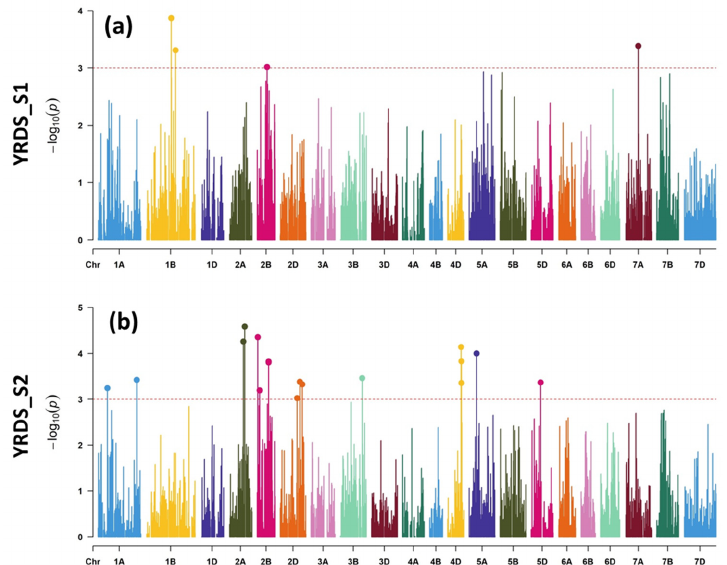
Figure 5. Genome-wide scan of ( a ) YRDS in S1 and ( b ) S2 in the form of Manhattan plots where the chromosomes are plotted at the bottom, and the thin dotted red line indicates significance level at p -value < 0.001 ( − log10 = 3 or more) beyond which an association is counted as true association (highlighted dots).